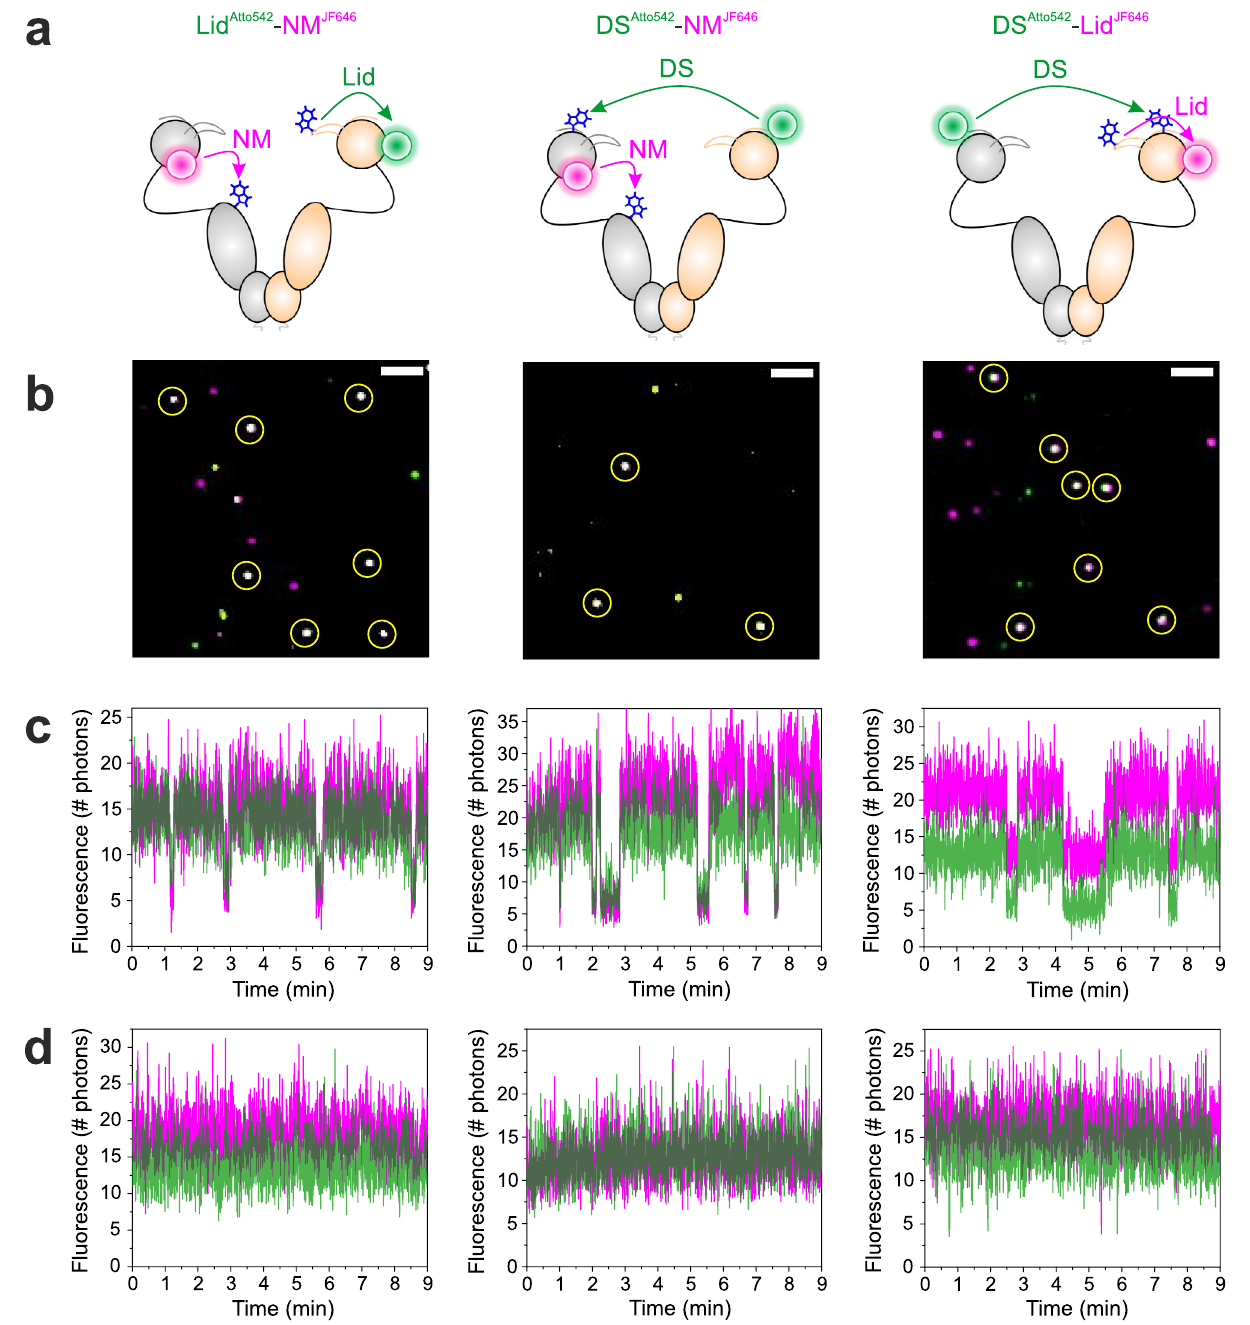
Fig. 4 Two-colour smPET fl uorescence microscopy of Hsp90 dynamics. a Two-colour PET fl uorescence reporters on Hsp90 for the simultaneous observation of Lid, DS and NM-association, illustrated as structural models. Fluorophores and Trp are indicated by coloured spheres and blue sticks. The reported conformational changes are indicated by arrows. b Representative two-colour smTIRF images of two-colour PET reporter-containing Hsp90 constructs tethered to glass surfaces (green: Atto542 fl uorescence, magenta: JF646 fl uorescence). Dually labelled Hsp90 dimers were identi fi ed by co- localization of Atto542 and JF646 fl uorescence signals (white spots, highlighted by yellow circles). White bars are 1- µ m scale bars. c , d Representative two-colour fl uorescence intensity time traces recorded from individual Hsp90 molecules containing two-colour PET reporters indicated in panel a . Traces measured in the presence of 4 mM ATP are shown in c . Traces measured in the absence of ATP are shown in d . Panels arranged in vertical columns belong to the same construct (speci fi ed in a ). Experiments were repeated three times with similar results. Source data are provided as a Source Data fi